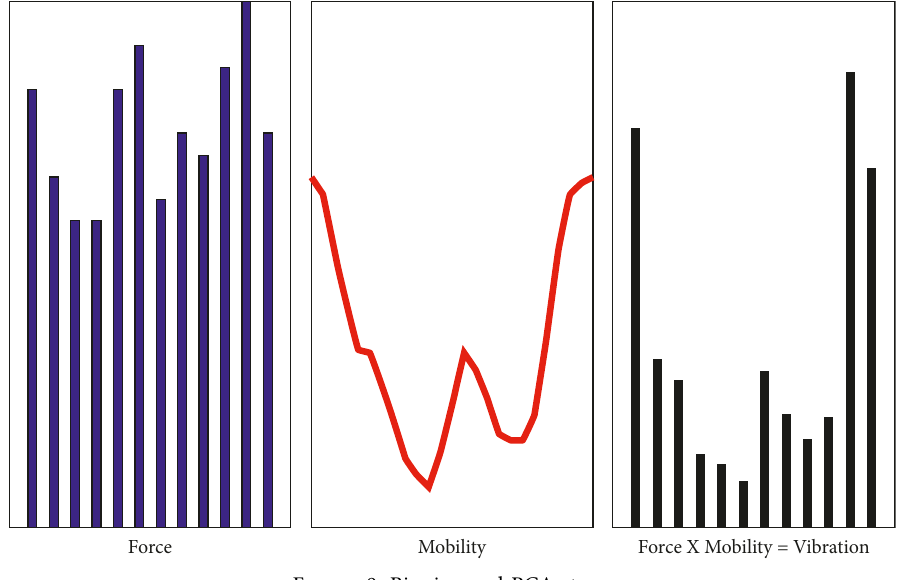
Figure 9: Binning and PCA steps.